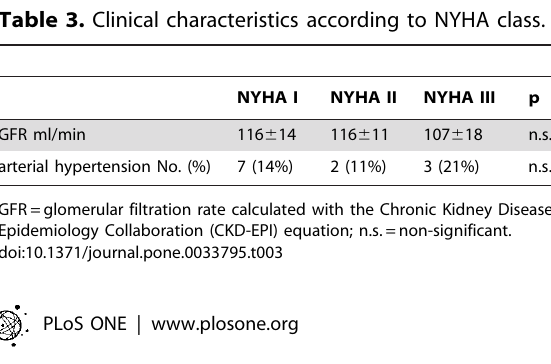
Congenital heart defect